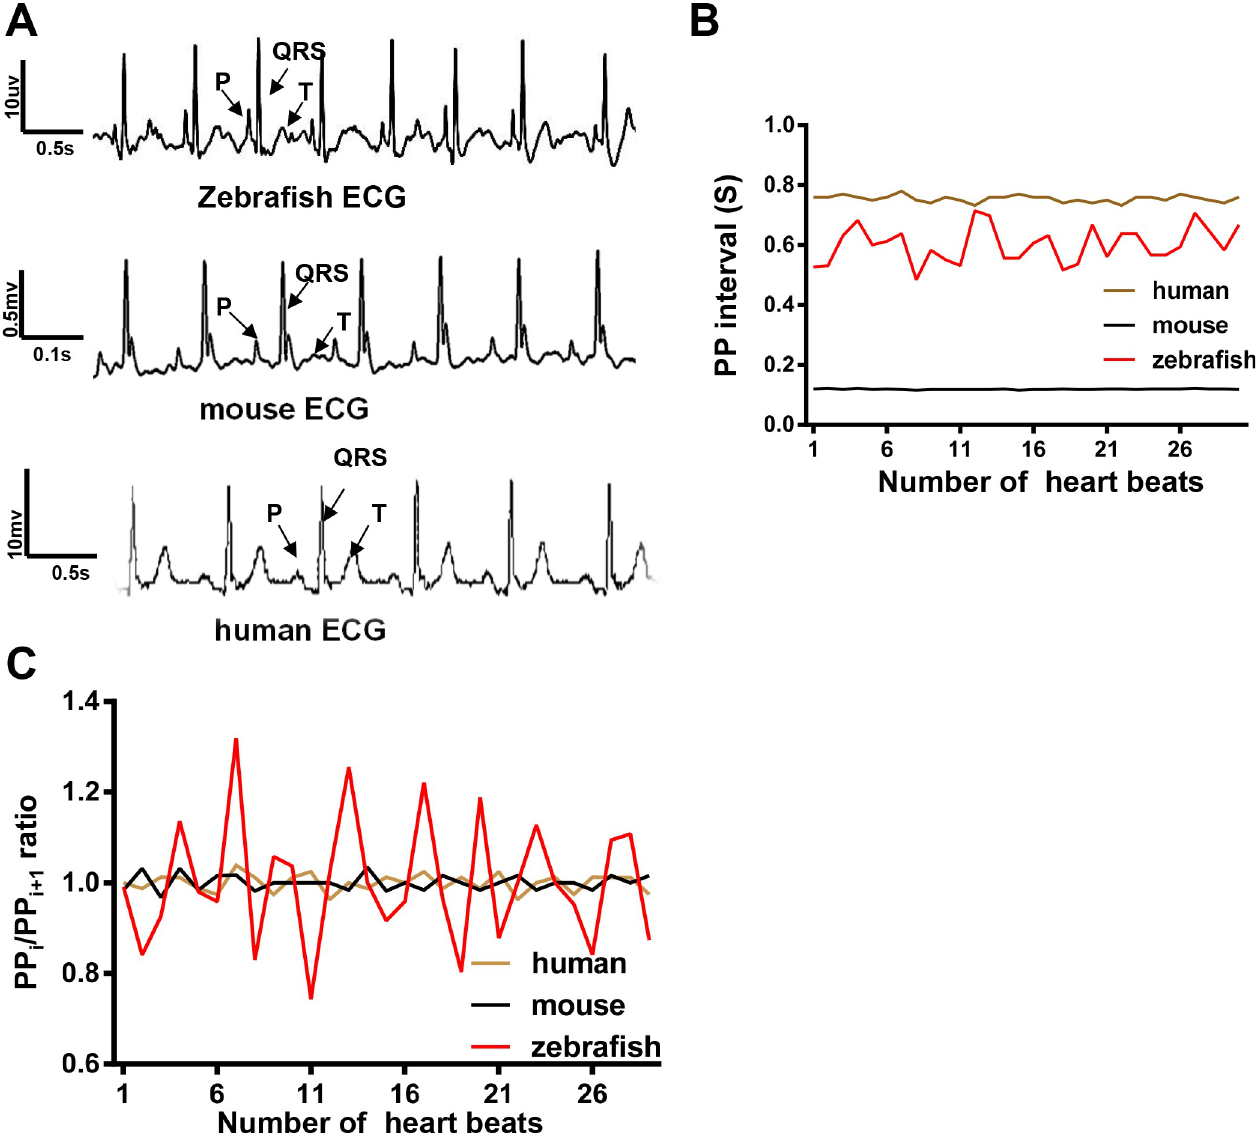
Fig 3. Heart rate was more variable in zebrafish than in mice and humans under anesthesia. A, Electrocardiographic (ECG) waveforms with distinguishable P, QRS, and T waves were similar in zebrafish, mice, and humans. B, Heart rate variation (HRV) was measured by quantifying average PP intervals every 30 beats in a representative fish, mouse, and human. HR in the zebrafish was similar to that in a human but was much higher than that in a mouse. HRV in zebrafish was larger than that in both a mouse and a human. C, HRV was measured by quantifying PP i /PP i+1 (ratio of 2 adjacent PP intervals) in a representative fish, mouse, and human. The ratio in a zebrafish was much larger than that in both a mouse and a